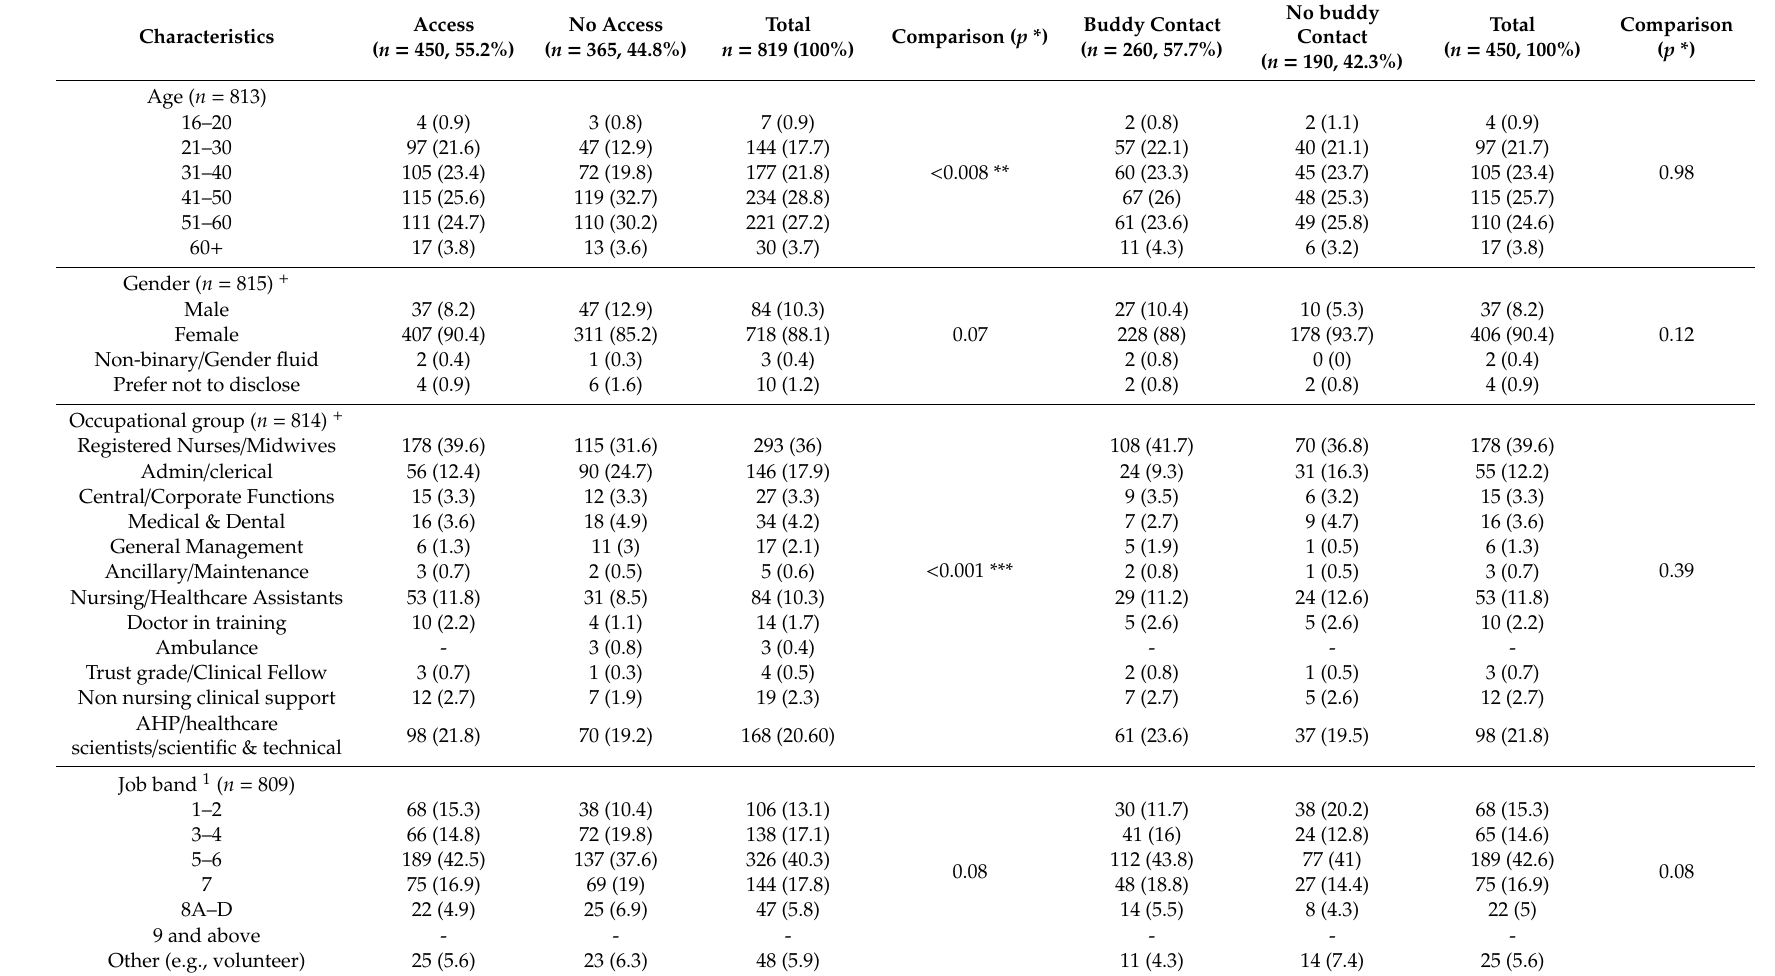
Table 5. Participant characteristics by centre use and buddy